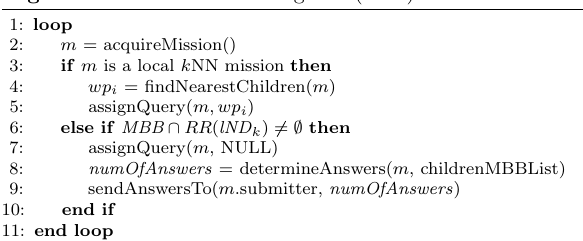
Algorithm 8 k NN Subscribing MP ( k SM)